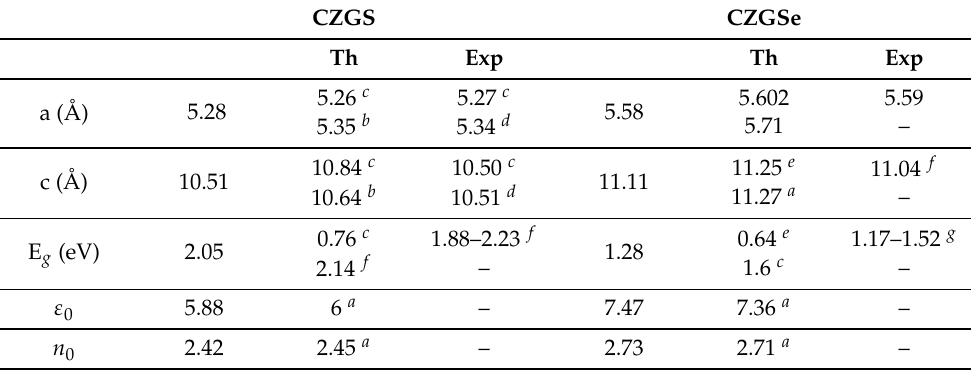
Table 1. Calculated lattice constants a and c, band gap energy E g , static dielectric constant ε 0 , and refraction index n 0 by DFT/PBE + (mBJ + U) approach for CZGS and CZGSe quaternary semiconductor